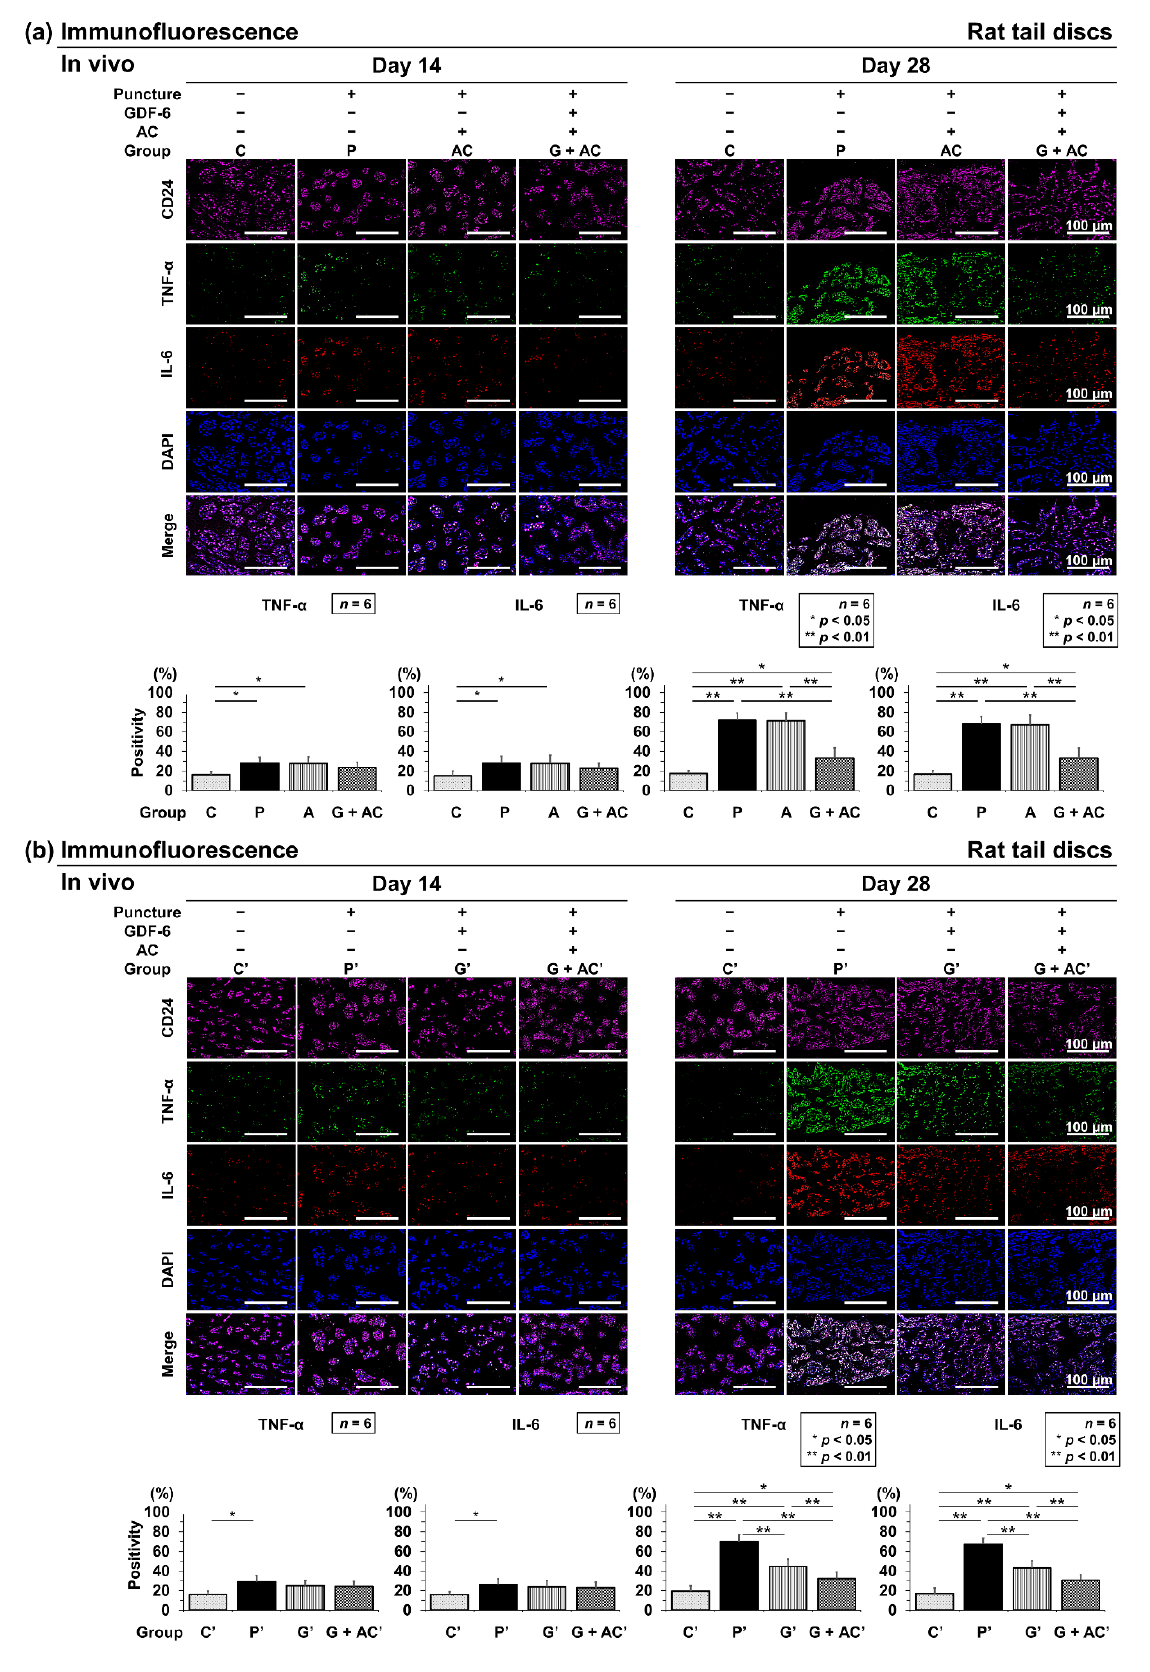
Figure 8. ( a ) Effects of co-administration of growth differentiation factor-6 (GDF-6) and atelocollagen (AC) on tumor necrosis factor- α (TNF- α ) and interleukin (IL)-6 expression compared with AC